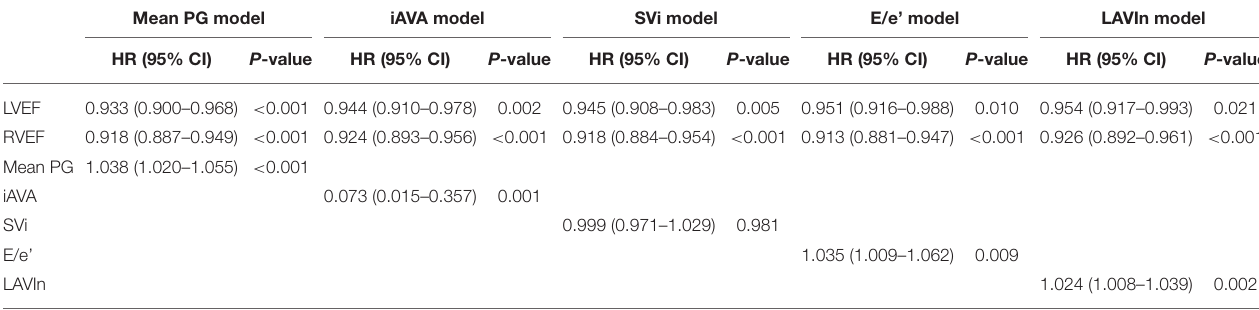
TABLE 4 | Multivariate Cox regression analyses after adjusting Charlson index and AVR as time-dependent covariates.